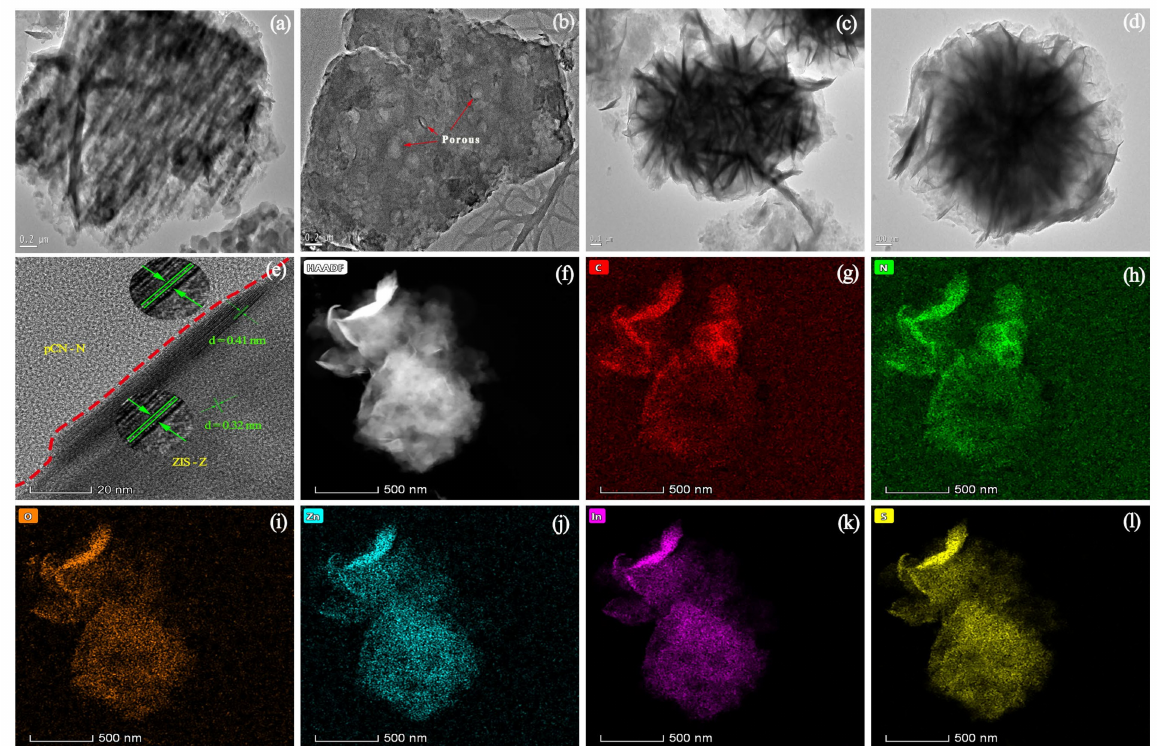
Figure 3. TEM images of bulk CN ( a ), pCN-N nanosheets ( b ), ZIS-Z nanosheets ( c ) pCN-N/ZIS-Z nanocomposite ( d ),